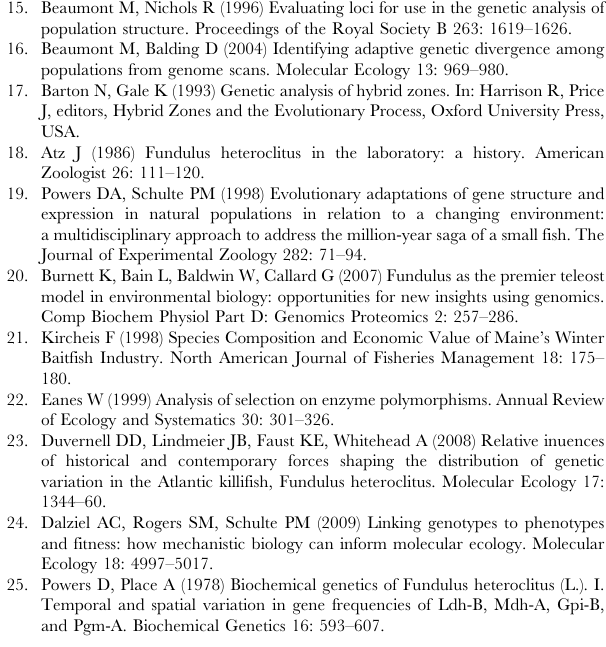
Figure S1 Examples of three model fits to clinal data for two loci. Red corresponds to a logistic fit, green a broken-stick fit, and blue a linear fit. Panel on the left illustrates the similarity between the the logistic and broken-stick models in well-behaved clinal data with large differences in allele frequency between the ends of the cline. Panel on the right corresponds to a situation where a clinal pattern appears in the data, but a logistic fit would not converge using the nlme package available on the R package repository (cran.r-project.org) (PDF) Figure S2 Simulation results for: N e m ~ 40 , other condi- tions same as in manuscript. Symbols and notation employed in plot identical to figure 4 in main document. Note that while the slope of clinally varying loci is less steep, they have the same midpoint and the proportion of loci exhibiting clinal variation is comparable to those cases illustrated in the main document. (PDF) Table S1 Loci identified as outliers using Co-Co and fdist2